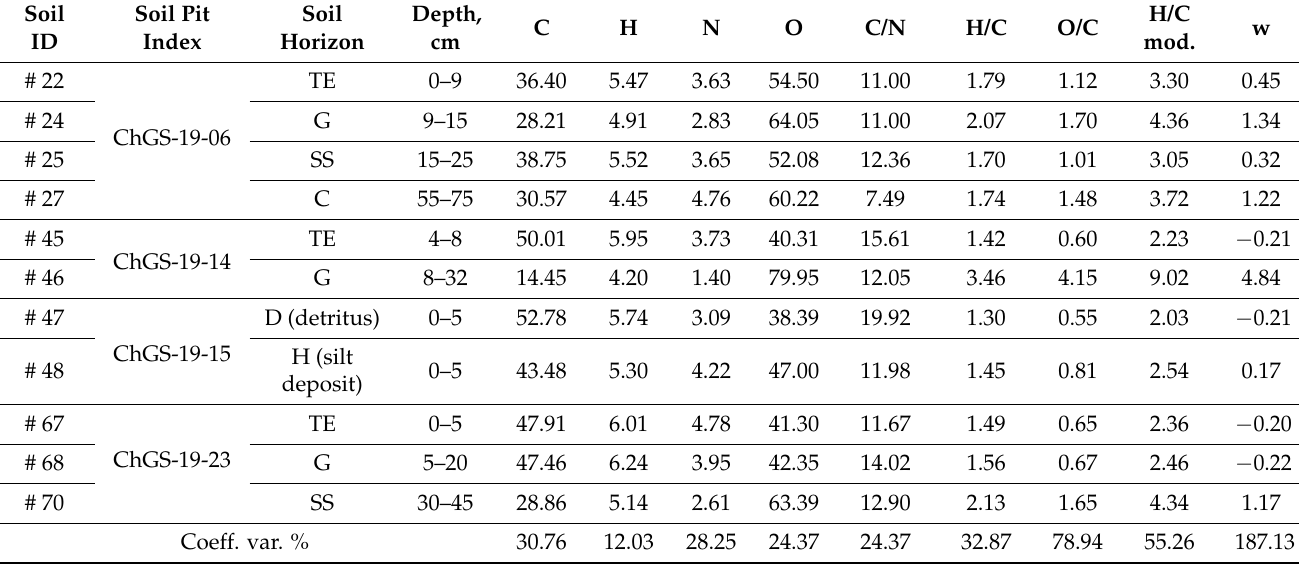
Table 2. Elemental composition of the studied HAs of isolated